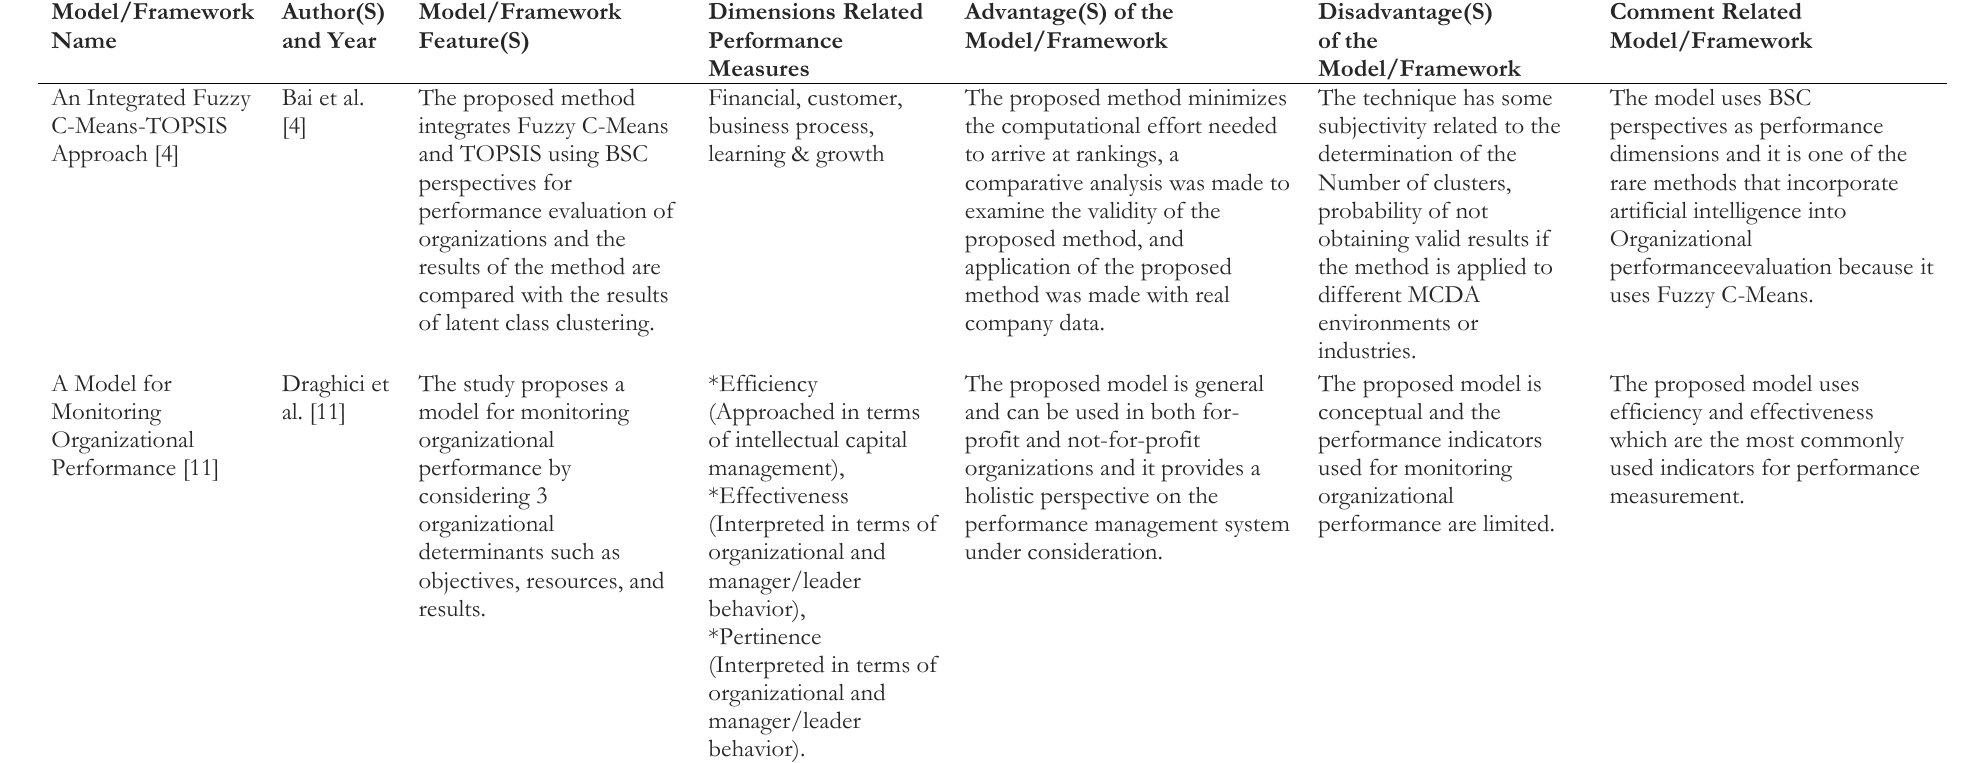
Table 1. Organizational performance measurement models developed in Industry